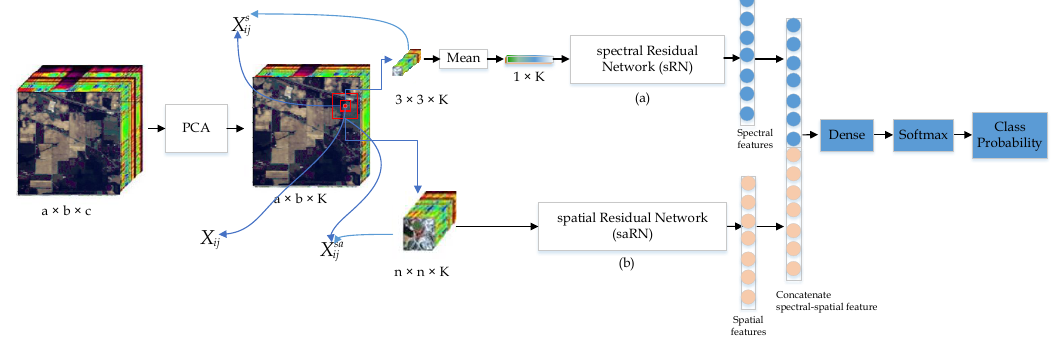
Figure 1. Proposed Two-Stream Spectral-Spatial Residual Network (TSRN) architecture. The details of spectral residual network (sRN) and spatial residual network (saRN) sub-networks are shown in Figure